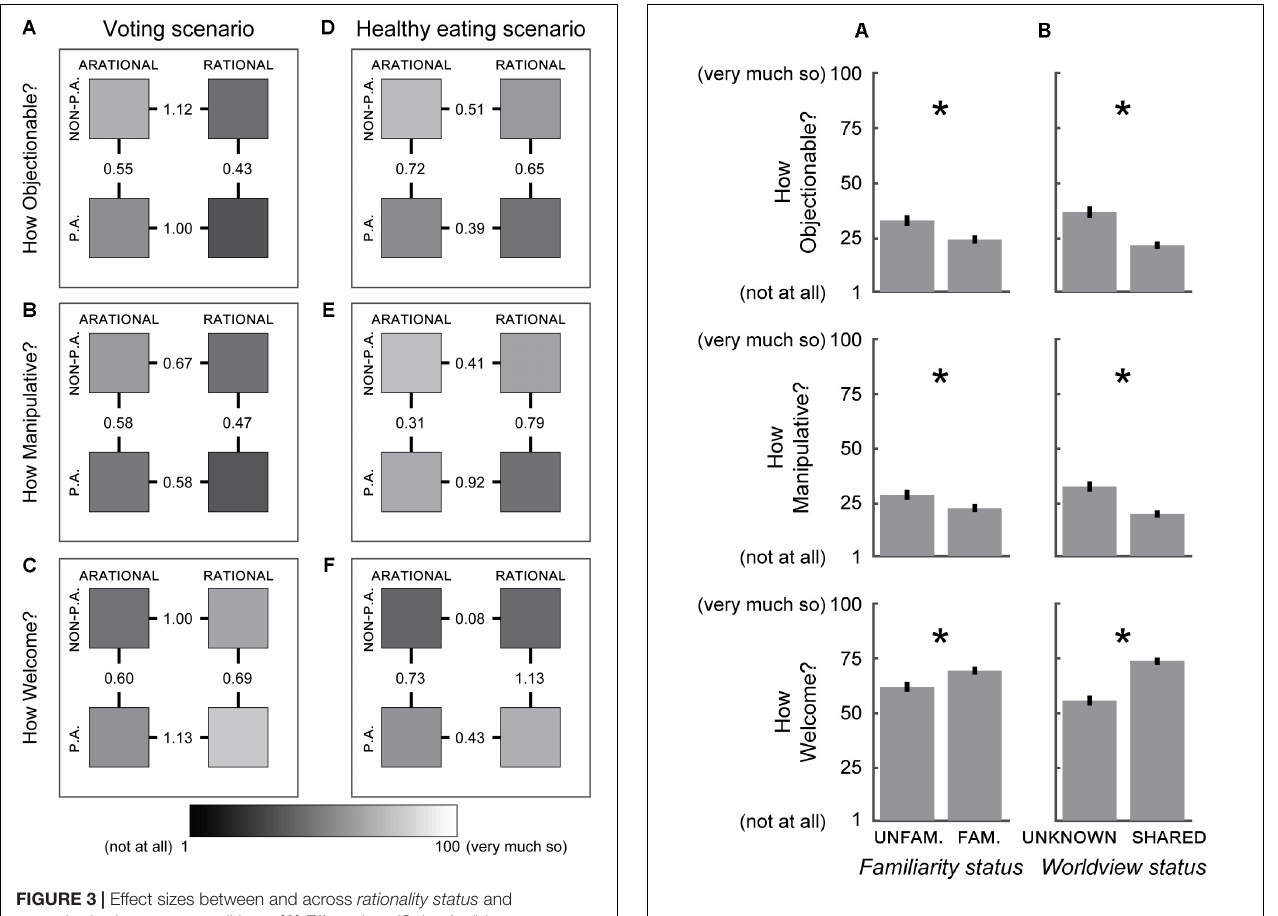
FIGURE 4 | Effect of familiarity status and worldview status on the extent to which an influence was perceived as undue. (A) An influence from an UNFAMILIAR source was perceived as more Objectionable (upper), more Manipulative (middle), and less Welcome (lower) than an influence from a FAMILIAR source. (B) An influence from a source with an UNKNOWN WORLDVIEW was perceived as more Objectionable (upper), more Manipulative (middle) and less Welcome (lower) than an influence from a source with a SHARED WORLDVIEW . Error bars ± SEM. ∗ p < 0.01, two-tailed unpaired t